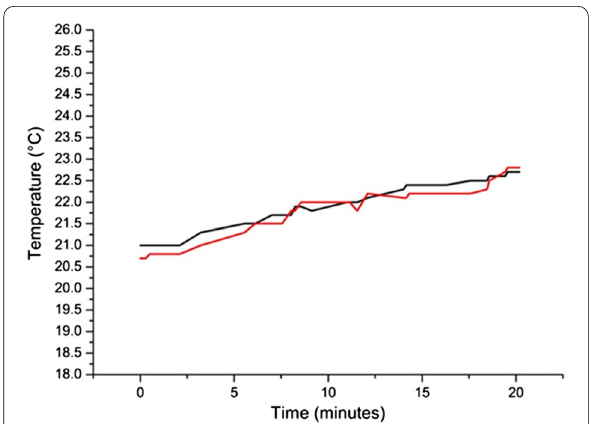
Fig. 1 Temperature trend measured using the FLIR Camera (black line) and the Fluke probe (red